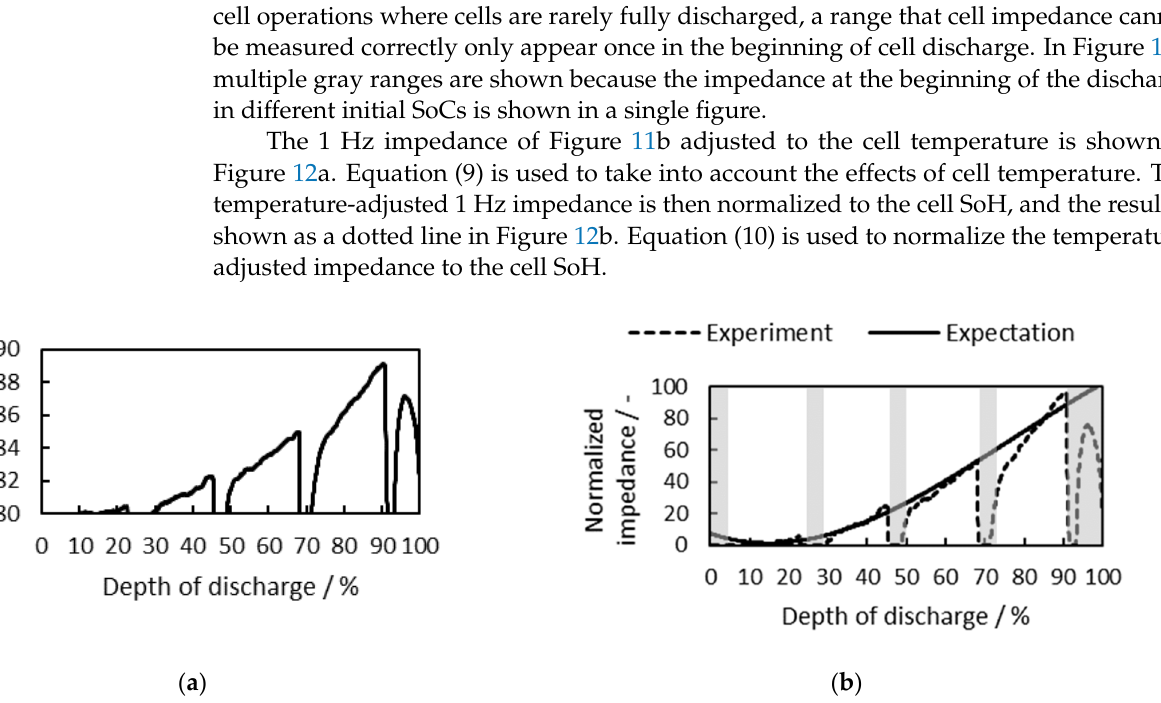
Figure 12. ( a ) 1 Hz impedance adjusted to cell temperature vs. DoD; ( b ) temperature-adjusted 1 Hz impedance normalized to cell SoH (dotted line) and expected value (solid line) vs. DoD.